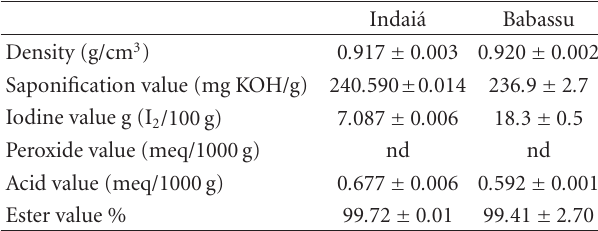
Table 1: Physicochemical analysis of indai´a and babassu oils.